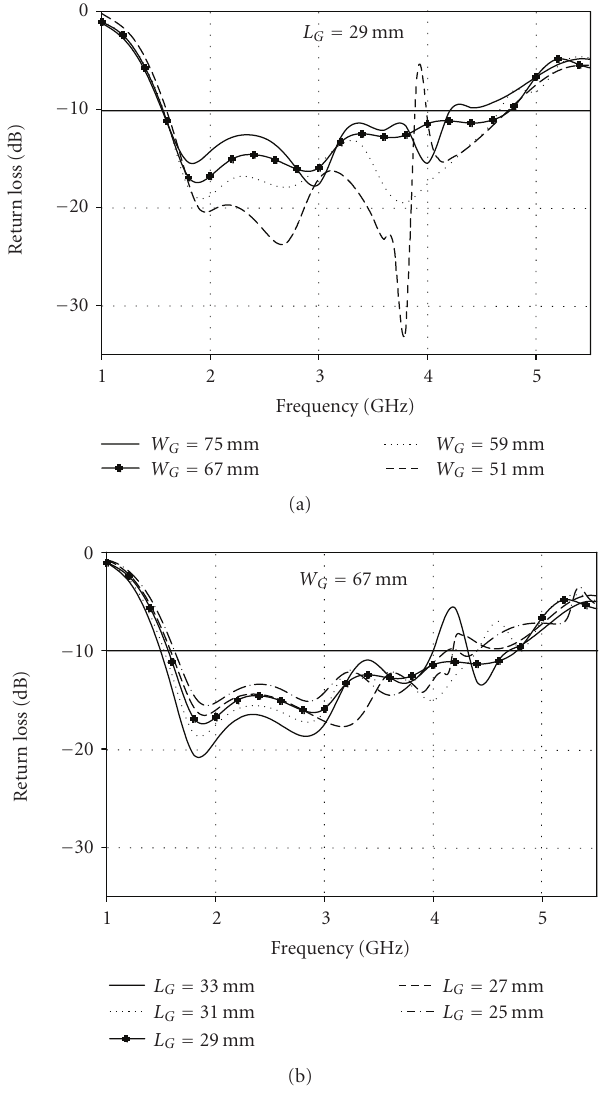
Figure 5: E ff ect of ground plane dimensions on the return loss characteristics: (a) W G variation [ L = 67, L G = 29, L M = 15, W . 5, L R S . 3, S . 5, W M = 3, R = 7 R = 19, R = 11, H 1 = 0 L 1 = 6 S . 25, h = 1 . 6 (Units in mm), ε . 4], (b) L S H 2 = 3, L 2 = 5 r = 4 G vari- ation [ L = 67, W G = 67, L M = 15, W M = 3, W R = 7 . 5, L R = 19, S . 3, S . 5, S S . 25, h = 1 . 6 (units in R R = 11, H 1 = 0 L 1 = 6 H 2 = 3, L 2 = 5 mm), ε r = 4 .